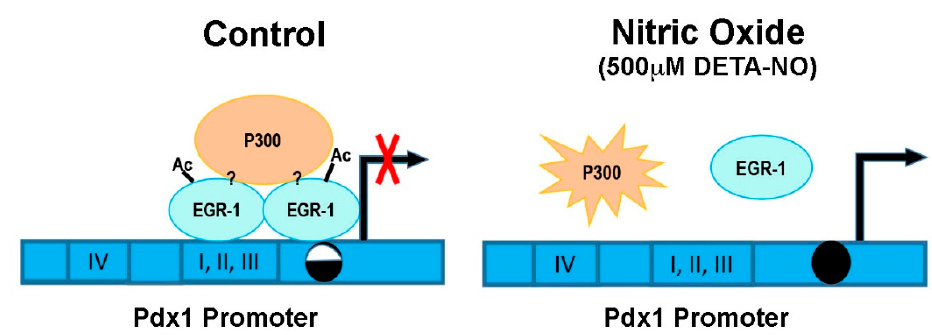
Figure 4. Overview of Pdx1 regulation by EGR-1 and P300 in mESCs. This graph represents the Pdx1 promoter in control and DETA-NO conditions. Control condition: mESCs cultured in medium supplemented with LIF. DETA-NO condition: mESCs cultured in medium supplemented with LIF and exposed to 500 µM DETA-NO for 19 h. I, II, III, and IV represent the conserved regulatory areas in the Pdx1 promoter. The circles represent the CpG site of the EGR-1 binding site studied on the Pdx1 promoter. Methylation grade is shown by the circle color (white and black: 40–60%; black: 80–100%). Question marks (?) symbolize that EGR-1/P300 interaction and the role of other proteins in regulating Pdx1 expression remain to be elucidated. Ac (acetylation); diethylenetriamine nitric oxide ad-